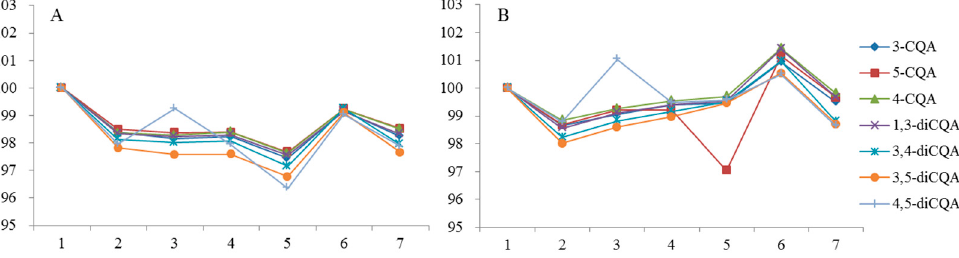
Figure 4. Photostability of CQAs in solution of 50% ( v / v ) aqueous methanol stored at 4 °C. ( A ) Brown bottle; ( B ) Transparent bottle.